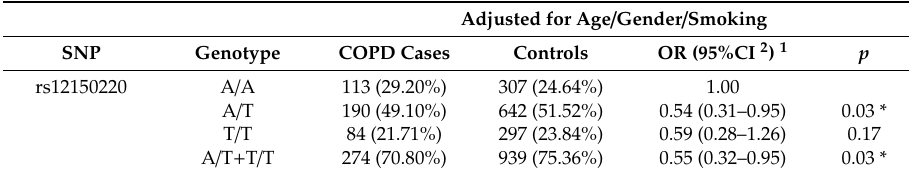
Table 4. Genotype frequencies of tested single nucleotide polymorphisms (SNPs) in the COPD cases and the control population and their associations with COPD adjusted for age, gender and smoking status. Adjusted for Age / Gender / Smoking